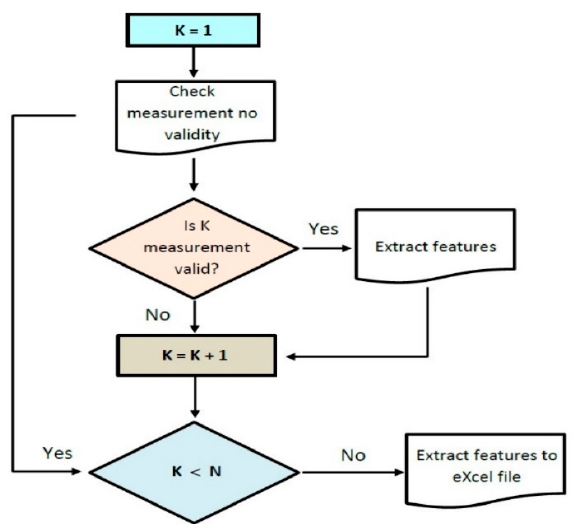
Figure 8. The algorithm for feature extraction from collected data belonging to all participants from a single study. K represents the current position of data; N represents the total number of measurements included; K = K + 1 represents the indexing of current position for all records to be passed through.